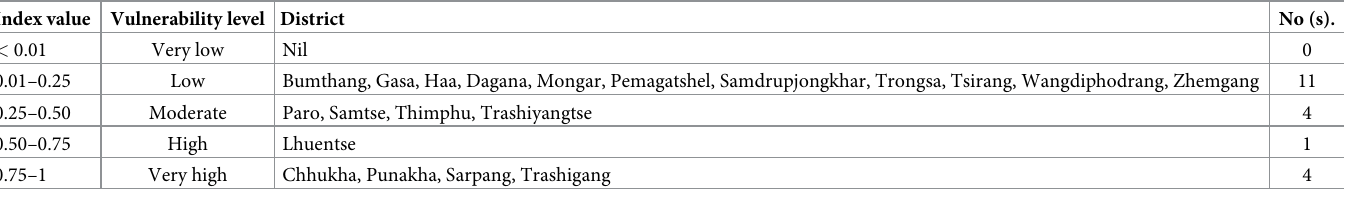
Table 11. Flood vulnerability